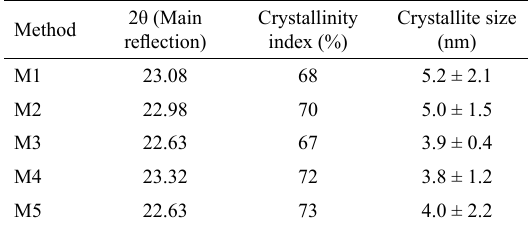
Table 1. Crystallinity index and Crystallite size values of the